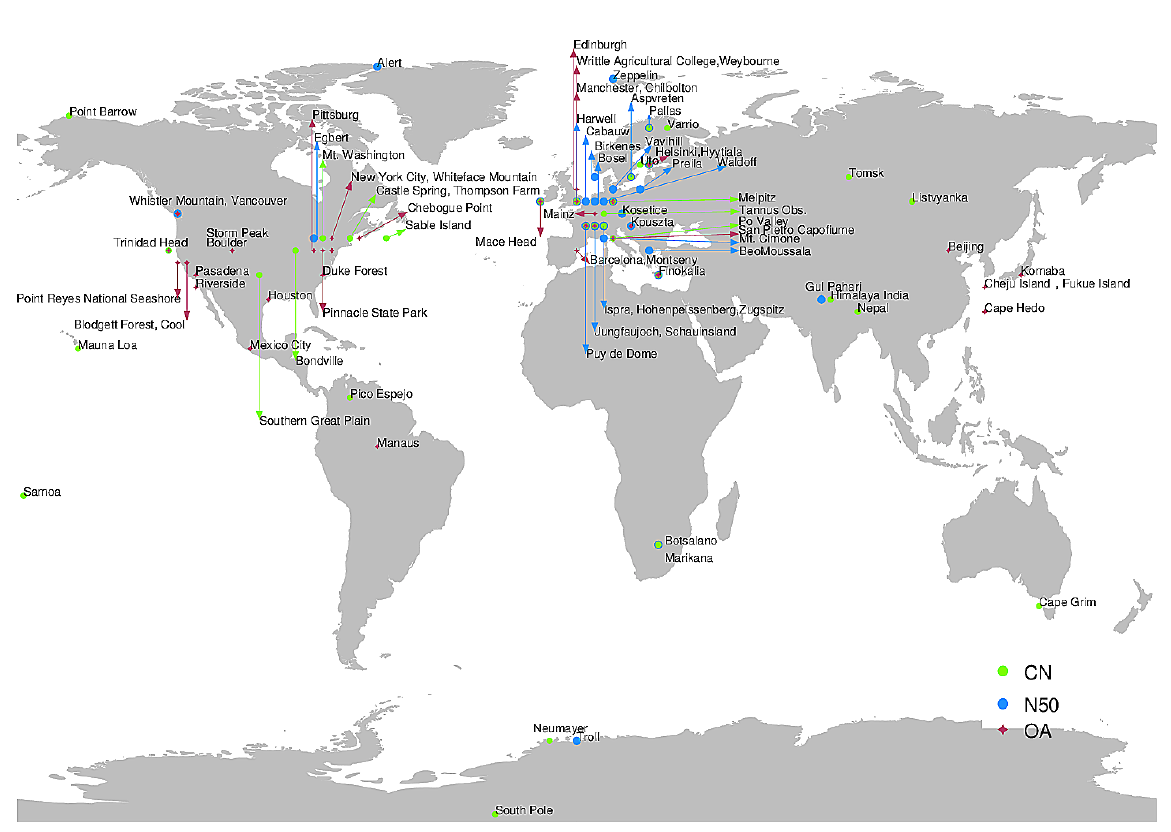
Figure 3. Locations of ground-based sites where model–observation match is compared for N3 (34 locations, symbols in light), N50 (31 locations, symbols in blue), and OA (41 locations, symbols in